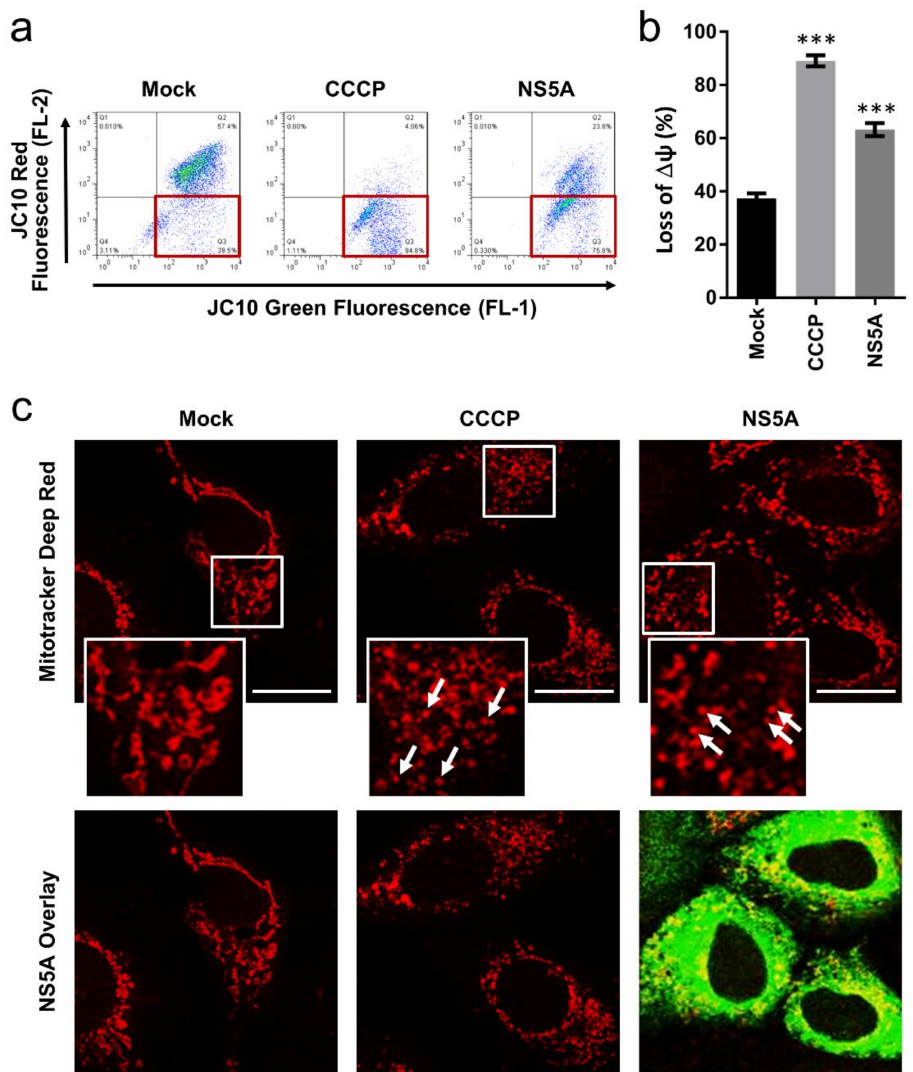
Figure 2. NS5A depolarizes the mitochondria and induces mitochondrial fragmentation. ( a ) Mitochondrial depolarization induced by NS5A overexpression in Huh-7.5 cells. Cells were transfected with NS5A for 48 h after which they were harvested for flow cytometry analysis using JC10 Membrane Potential Kit. Quadrant shift indicative of loss of MMP is demarcated in red. ( b ) Quantification of a. ( c ) Mitochondrial fragmentation analysis in NS5A-overexpressing Huh-7.5 cells. Huh-7.5 cells were transfected with or without NS5A on a glass slide for 3 days; CCCP treatment (10 µ M) was used as positive control. The samples were stained with MitoTracker Deep Red and fixed with 4% PFA, after which the cells were stained with anti-NS5A antibodies. Magnification = 630 × ; scale bar = 20 µ m. Demarcated areas (white squares) are shown with arrows indicating fragmented mitochondria. Results are from 3 independent experiments with errors bars indicating mean ± SD; representative flow cytometry plots and micrographs are shown. Asterisks (*) denote statistical significance compared with mock: *** p <